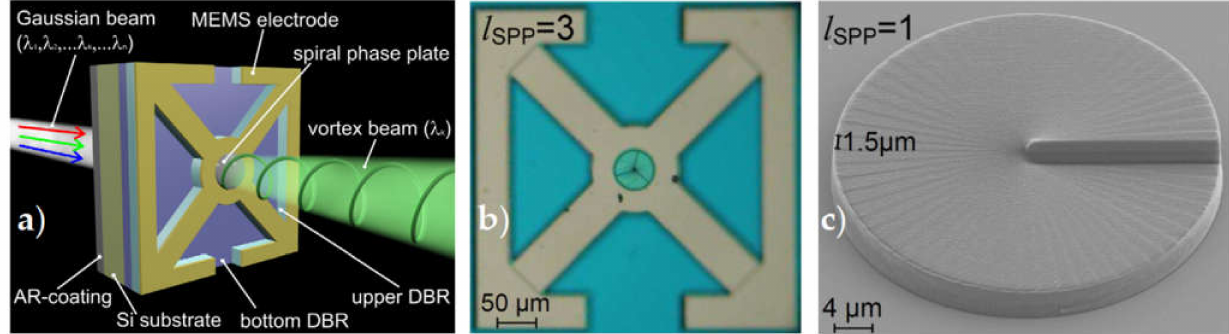
Figure 10. ( a ) Scheme of an OV MEMS Fabry-Perot filter: AR-coating = anti-reflection coating, and DBR = distributed Bragg reflector [160]. ( b ) Top view of a MEMS tunable Fabry-Perot filter with an integrated SPP [160]. ( c ) SEM image of a SPP of order l SPP = 1 on a plane Si substrate